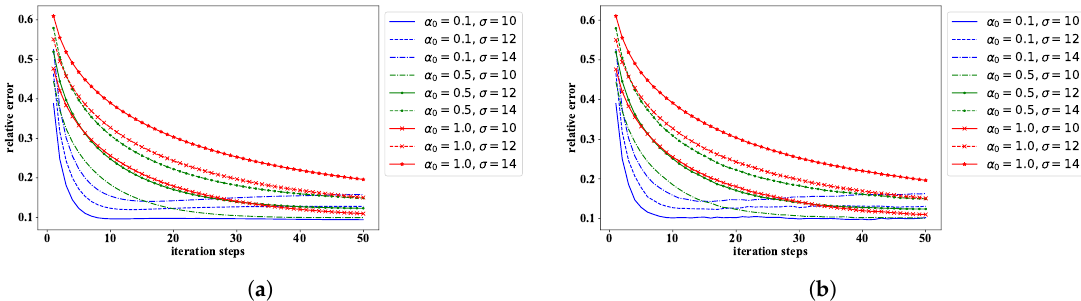
Figure 2. The variation of relative error of different α 0 with various conductivities: ( a ) when SNR = 40 dB and ( b ) when SNR = 20